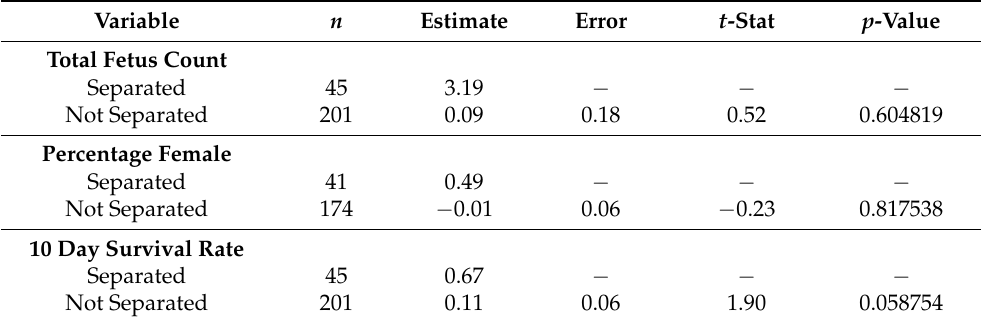
Table 7. Analysis of strain 13/N guinea pig breeding outcomes based on the separation of pairs following the breeding period. Breeding couples that were not separated (continuously paired) were compared to those separated prior to breeding (new pairing).